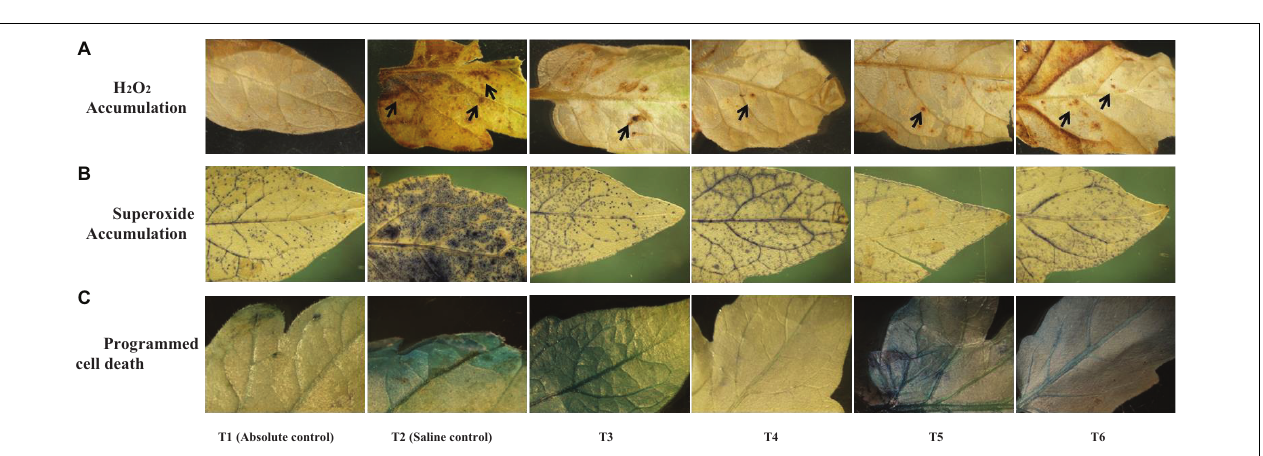
FIGURE 4 | Effect of bacterial endophytes on enzymatic antioxidants under elevated salinity (150 mM NaCl). (A) Peroxidase, (B) ascorbate peroxidase, (C) catalase, and (D) superoxide dismutase. T1, absolute control; T2, saline control; T3, BTL5; T4, GTR8; T5, GTR11; and T6, GTS16.